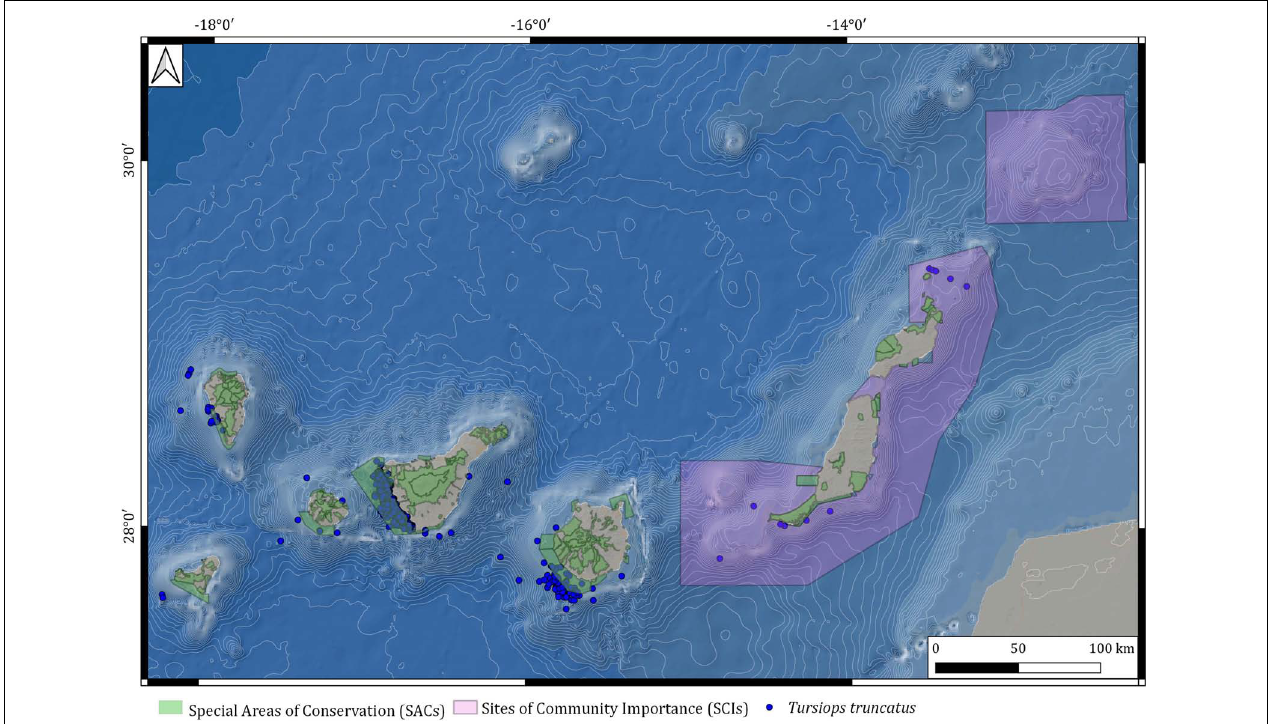
FIGURE 8 | Tursiops truncatus spatial distribution around the Canary archipelago (blue circles), including the Special Areas of Conservation (SACs; green color) and the Sites of Community Importance (SCIs; pink color).